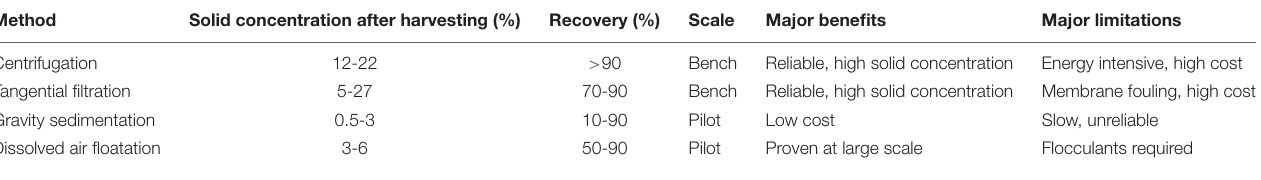
TABLE 5 | Comparison of mechanical harvesting methods for algae (Adapted from Teixeira and Rosa, 2006; Greenwell et al., 2009; Uduman et al., 2010).